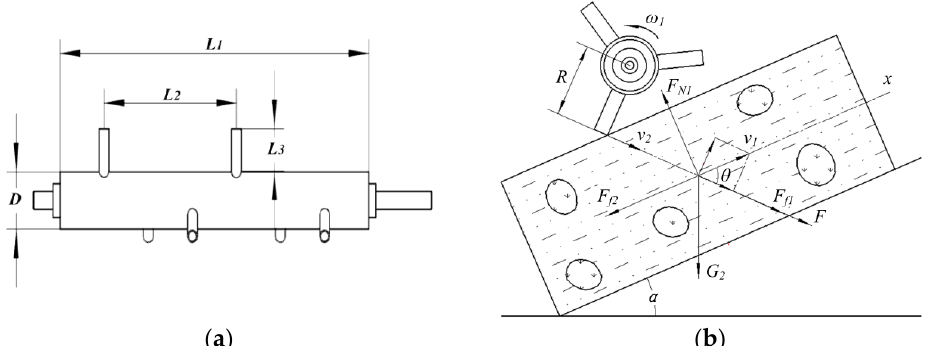
Figure 3. ( a ) The parameters of the soil-crushing mechanism; ( b ) The kinetic analyses of potato-soil mixture during the shearing area.